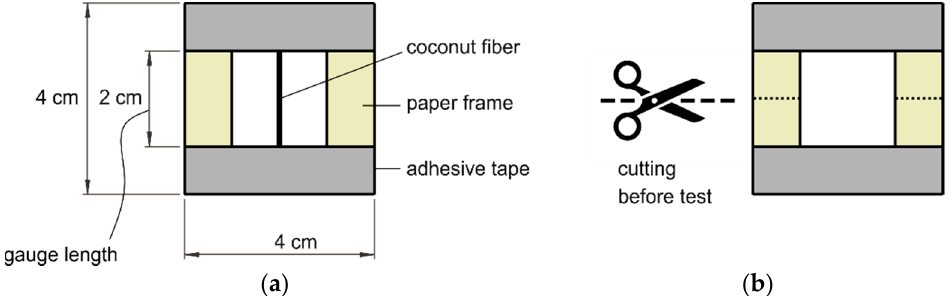
Figure 5. Single fiber specimen before direct tensile test: ( a ) transparency paper frame for fixing fiber; ( b ) cutting of the frame before fiber testing.